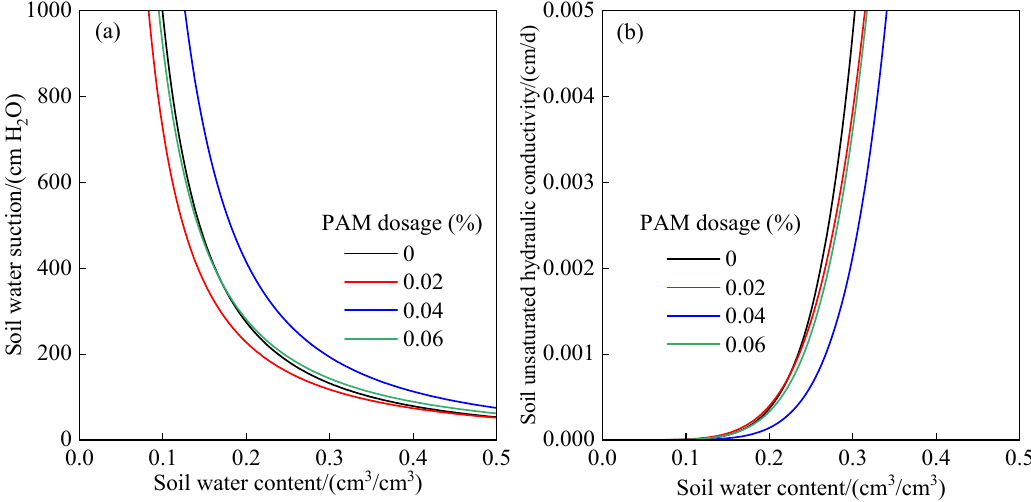
Figure 4. Soil water characteristic curve and unsaturated hydraulic conductivity curve under different PAM dosages. ( a )soil water characteristic curve, ( b ) unsaturated hydraulic conductivity curve.